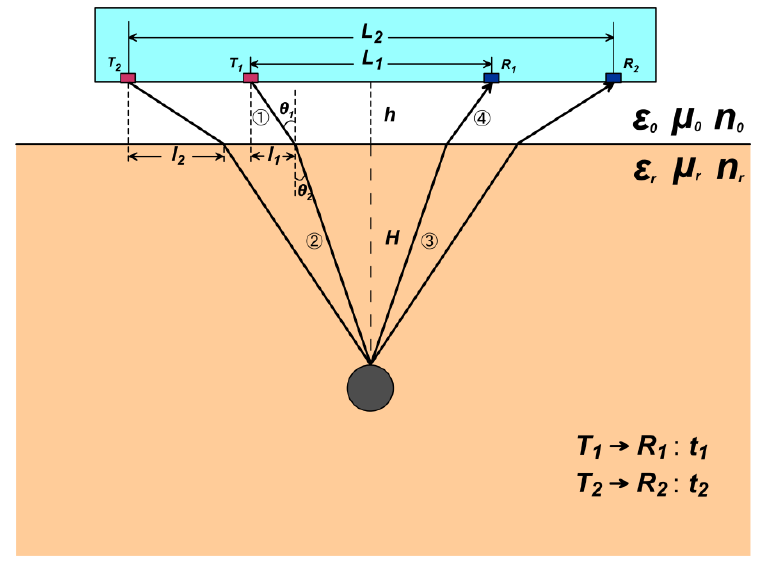
Figure 2. Schematic diagram of the second case (there is space between the radar and the ground).